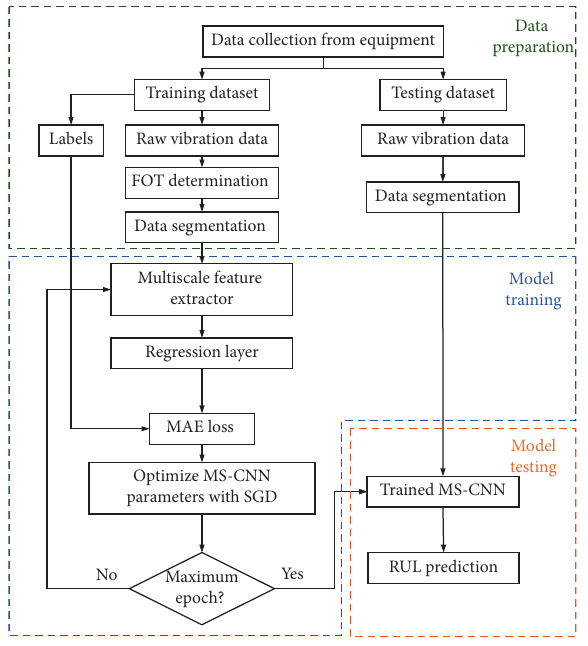
Figure 4: The flow chart of the proposed method.